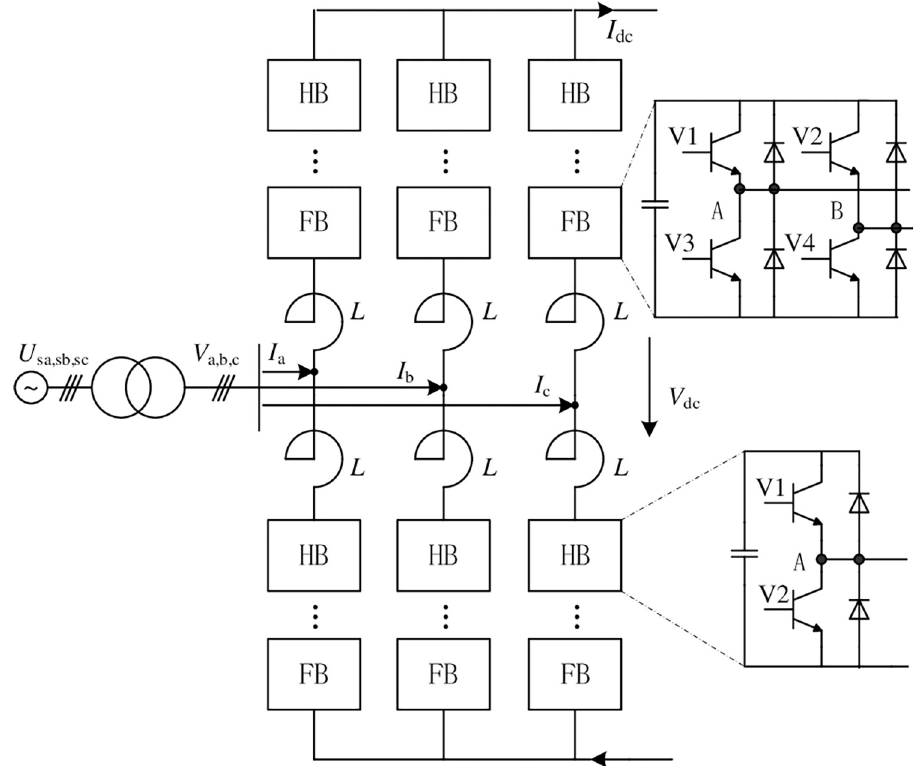
Fig 1. Circuit of hybrid MMC topology.